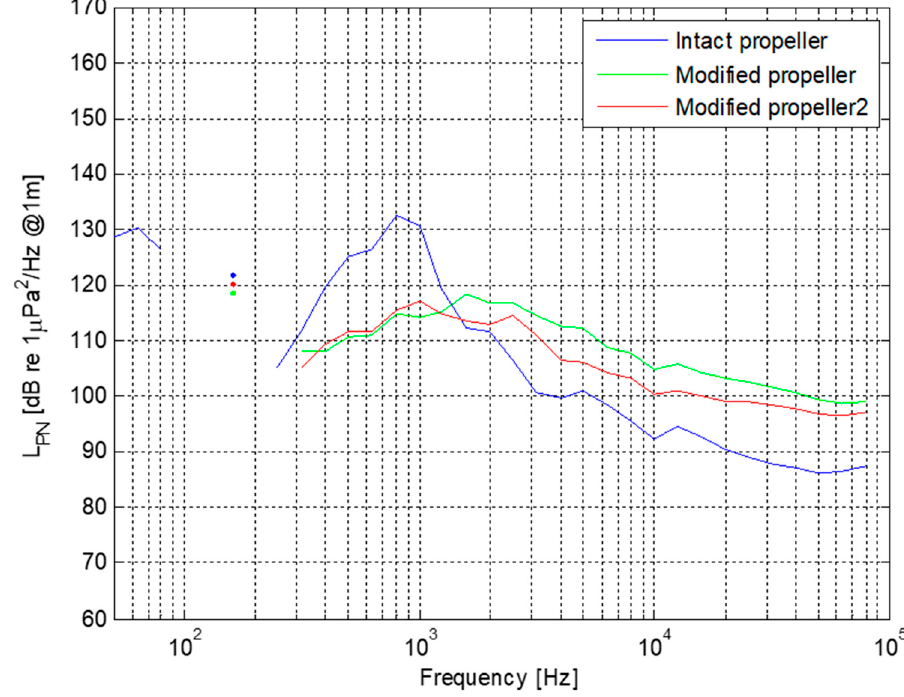
Figure 16. Comparison between Intact, Modified Propeller and Modified Propeller-2 net noise levels at 1 m (one third octave band), condition V1, hydrophone H3.